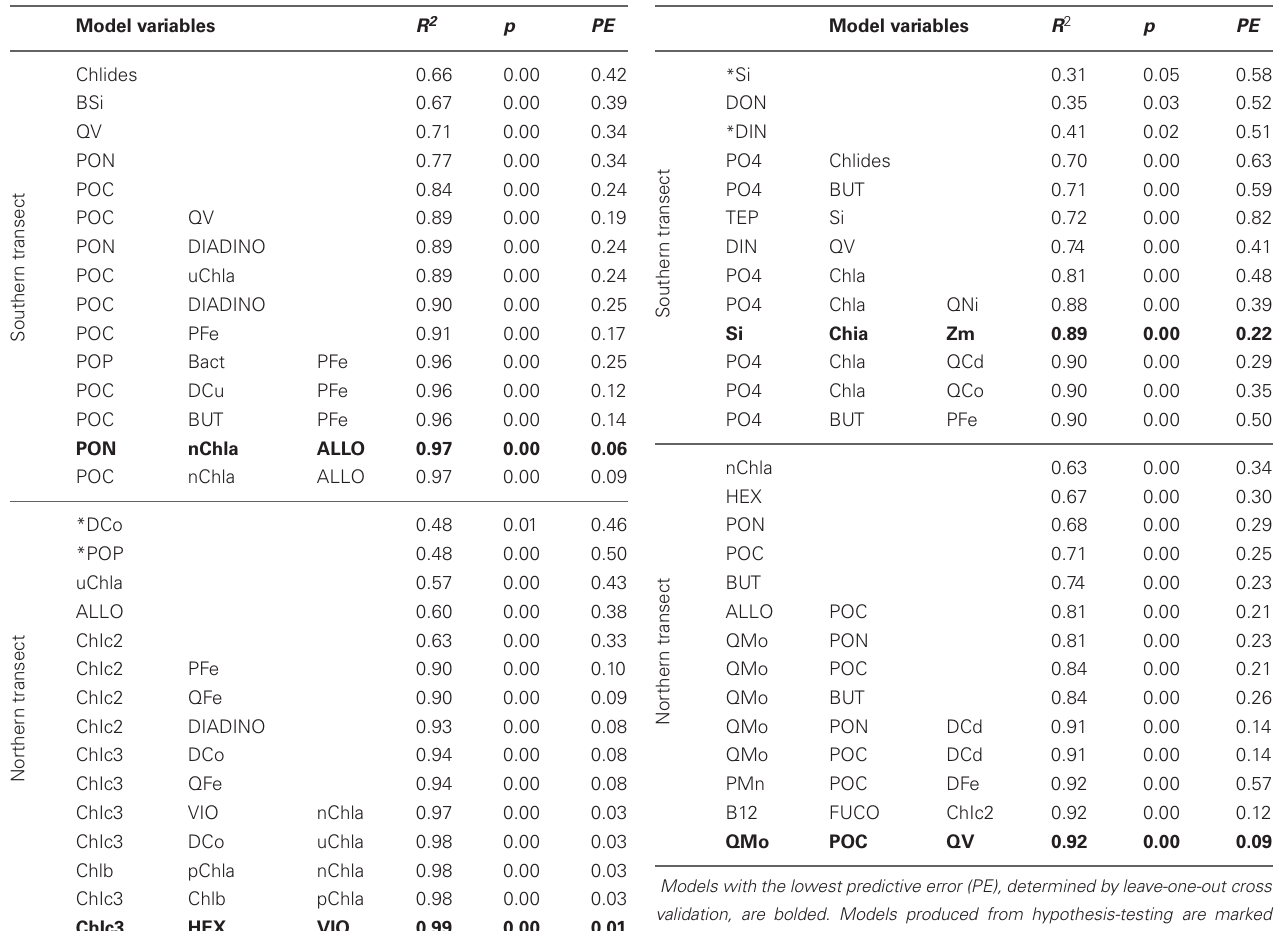
Table 3 | Linear models and diagnostic statistics for chlorophyll a, only statistically significant regressions for up to three variables are presented.